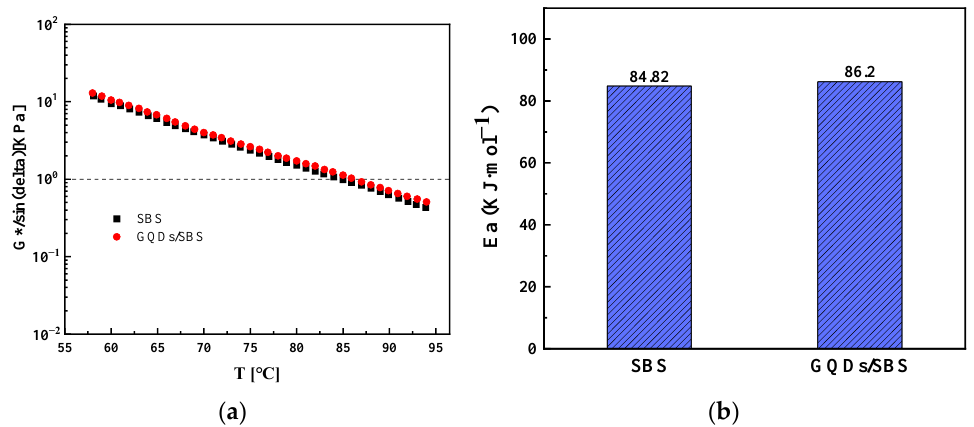
Figure 10. ( a ) Evolutions with temperature of the G*/sinδ and ( b ) Temperature calculated at the point of G*/sinδ = 1.0 KPa for SBS -modified asphalt and GQDs/SBS composite-modified asphalt.